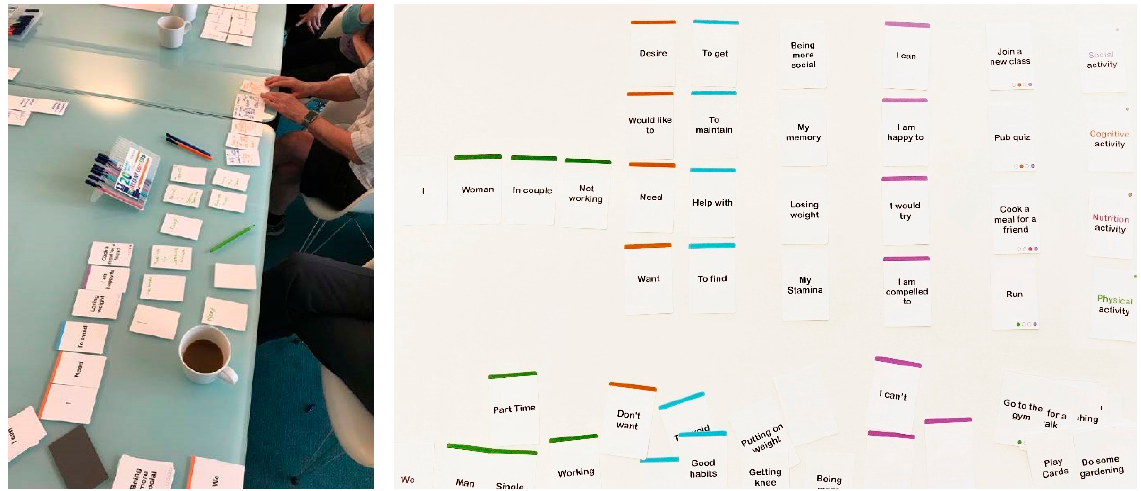
Figure 3. ( left ) Picture from the workshop, using both pre-printed and empty design cards. ( right ) example of a pathway choice process.